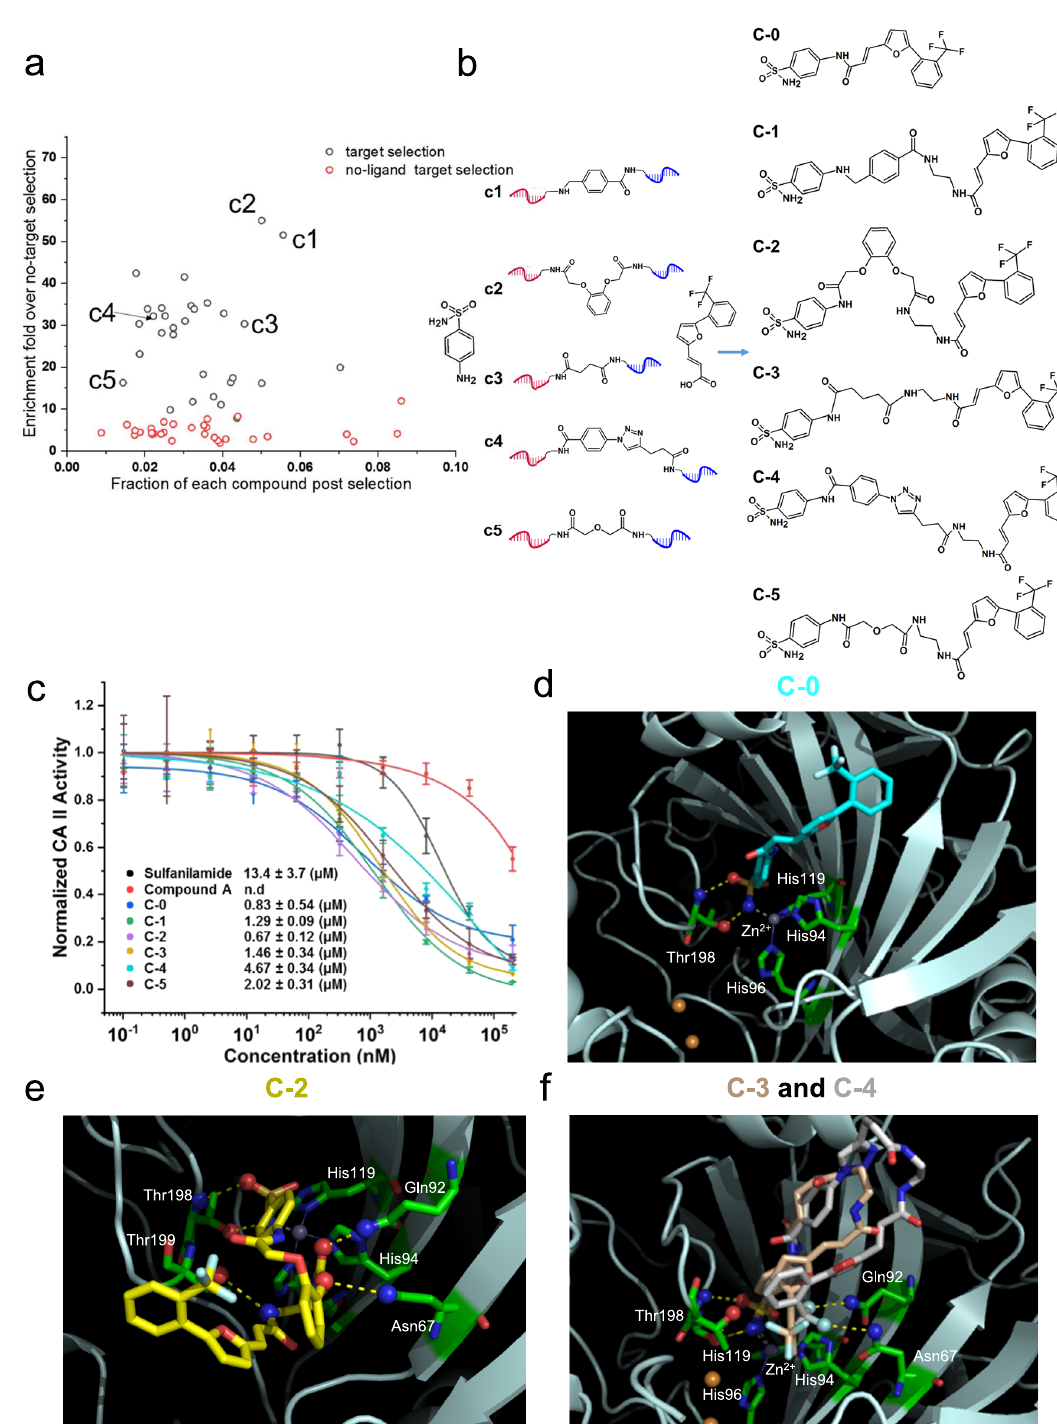
Fig. 2 | Af fi nity maturation ofligand pair against bovine carbonic anhydrase II (CAII).a Scatterplotoftheselectionoutcome. b Fiveconjugates(c1toc5)enriched fromtheselectionwithvaryingenrichmentfoldswerechosentolinksulfanilamide andcompoundA,generatingsmallmolecules(C-1toC-5)containingthreemoieties from the three sub-libraries. C-0 is a directconjugationbetween sulfanilamide and compound A. c Hit validation byanenzyme inhibitionassay. Data are presented as mean values±SD from three independent measurements. IC 50 values are pre- sented as mean values±SE. Data are presented as mean values±SD from three